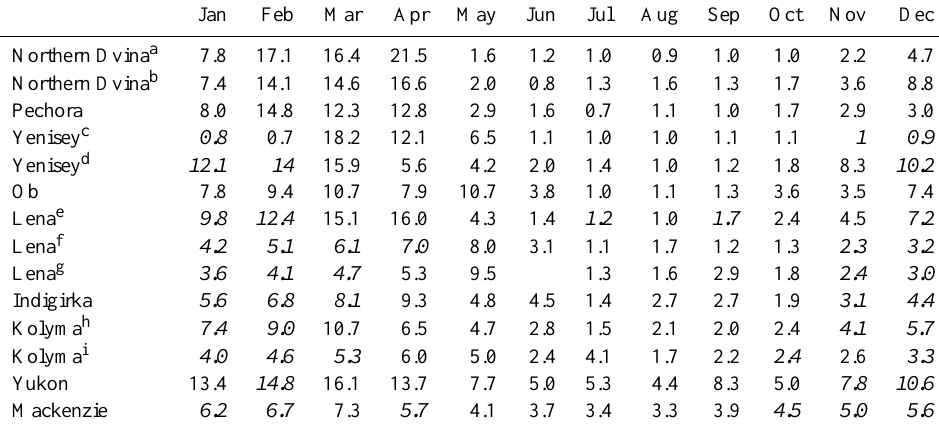
Table A1. Monthly-binned riverine concentrations of nitrate (mmolNm − 3 ) . Linearly interpolated values are shown in italic.